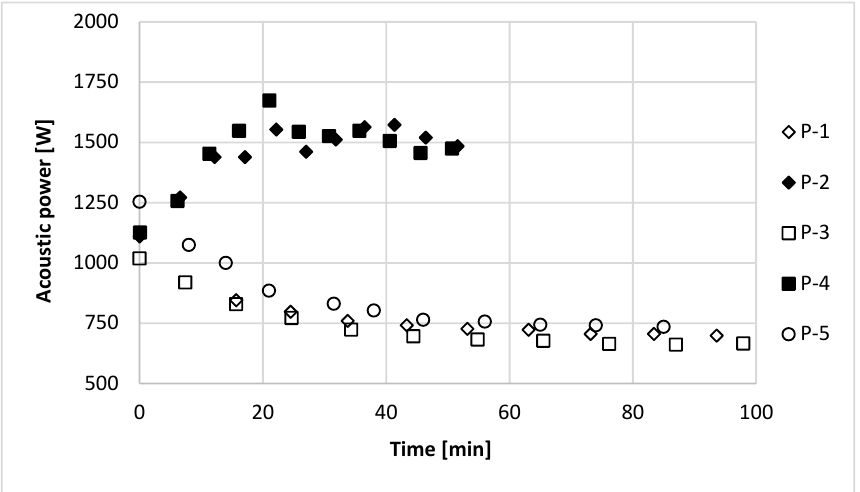
Figure 5. Acoustic power (W) evolution during the UAE at pilot-scale. Pressurized tests (full), non-